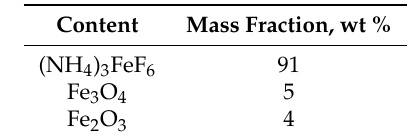
Table 4. XRD analysis of the solid residue by ammonium fluoride solution with concentration of 4.2 mol/L.